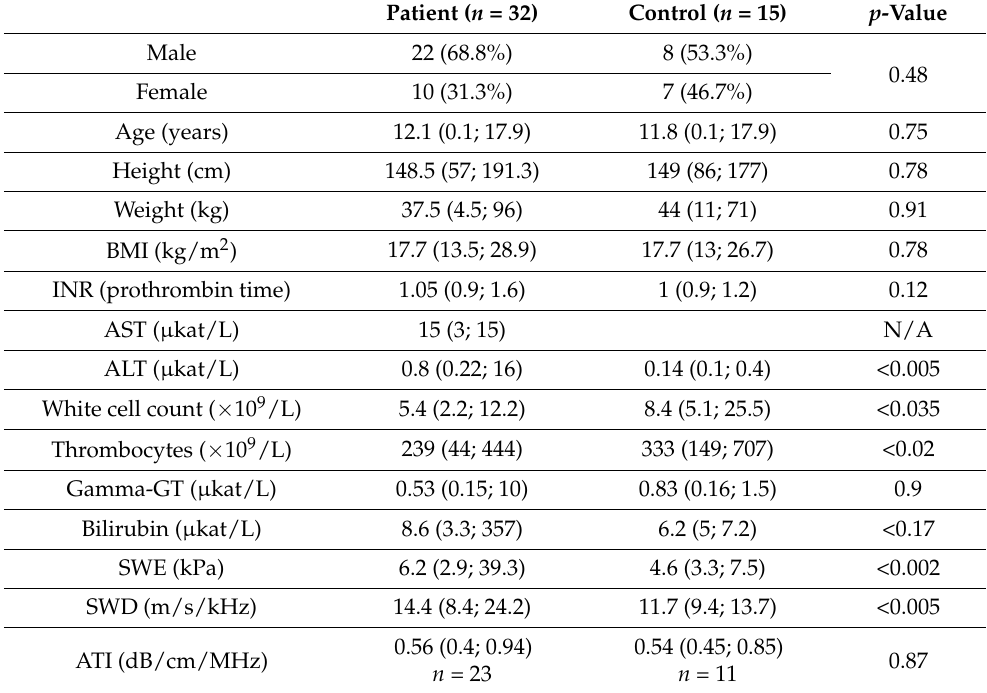
Table 4. Demographic data and serological and ultrasound-based markers in patients and